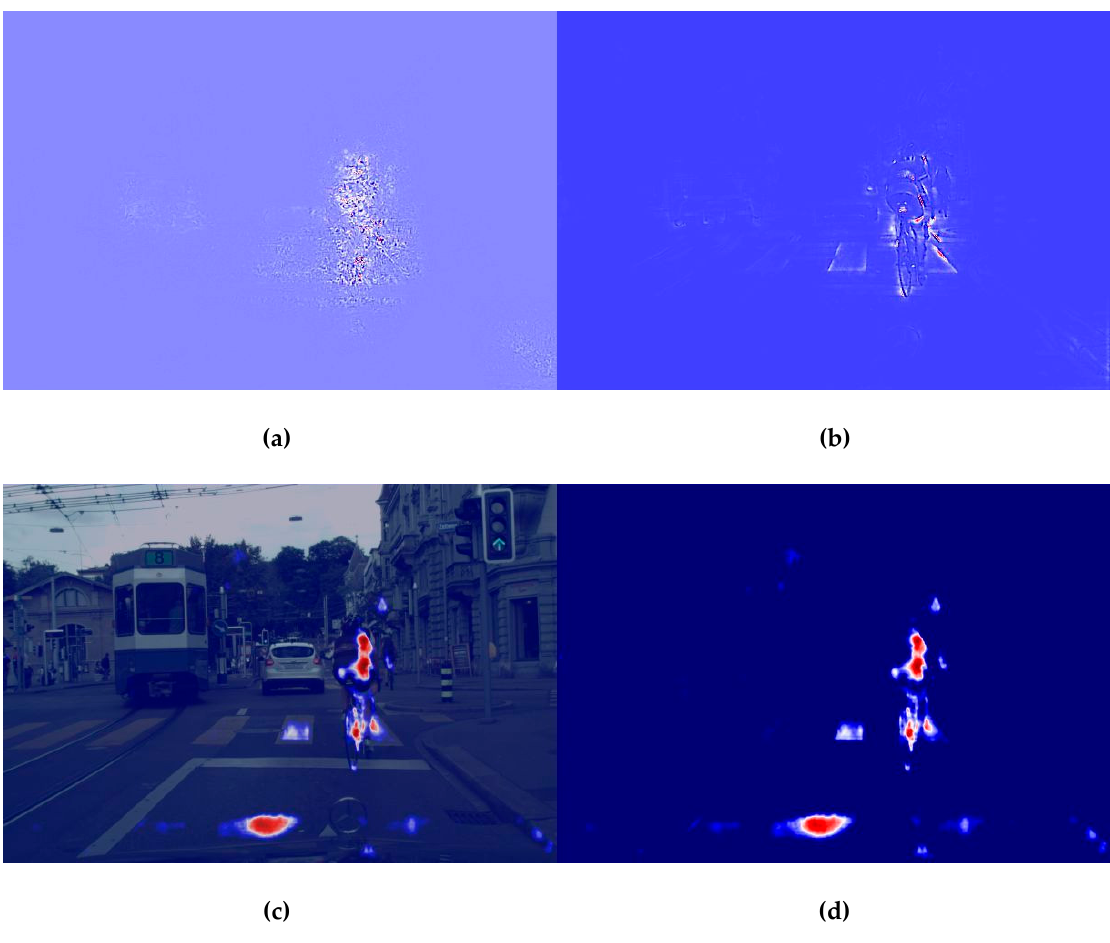
Figure 7. Different visualization methods for class ‘bicyclist’: ( a ) saliency map, ( b ) guided back-propagation, ( c ) Grad-CAM, ( d ) Guided Grad-CAM.3.2.2. Grad-CAM for Different Model